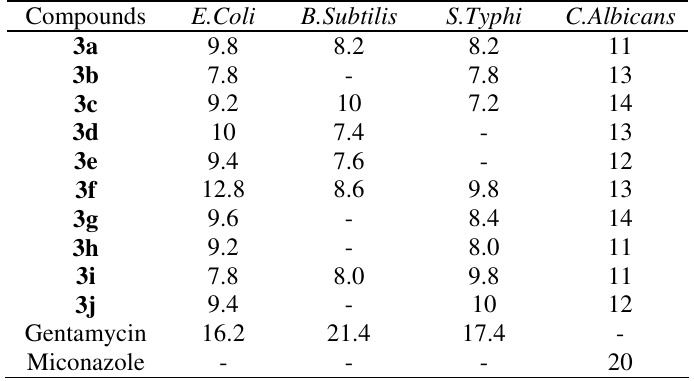
Table 1. Antimicrobial activity of compounds ( 3a-j